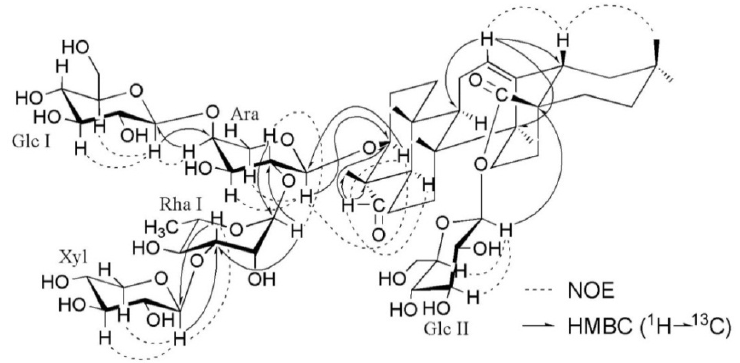
Figure 2. Key NOESY and HMBC correlations for compound 1